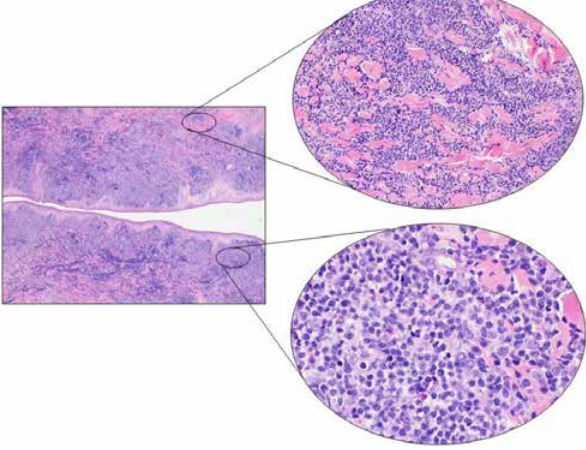
Figure 2 : Microscopic examination showed a dense lymphoid infil- trate involving the reticular dermis, sparing the epidermis and the most superficial papillary dermis (Grenz zone) (Left, H&E, 2x). The lymphoid population showed a diffuse growth pattern periphe- rally dissociating the collagen bundles. In the deep dermis, at the bottom of the proliferation, a granulomatous reaction was seen with multinucleated giant cells (Upper right, H&E, 20x). The cell population consisted of medium- and large-sized cells with poorly defined cellular borders, slightly eosinophilic cytoplasm, round- ish nuclei with irregular chromatin distribution and one or more prominent nucleoli. Several small mature T cells were present in the background (Lower right, H&E,